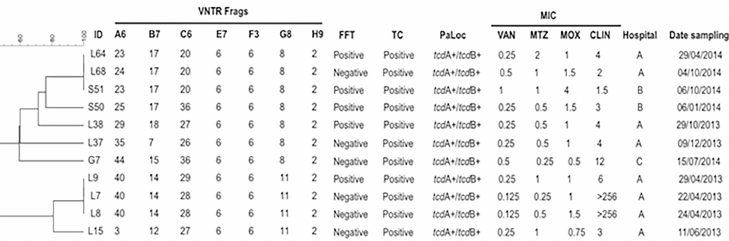
Fig 4. Analysis of ribotype 002 by MLVA. MLVA was applied to 11 isolates belonging to the ribotype 002. Dendrogram showing similarities of banding patterns generated with high-resolution capillary gel-based electrophoresis (CE)-PCR. MLVA clusters are identified by minimum-spanning tree: one clonal complex is defined by MLVA type with less than a two-locus difference. In addition, free fecal toxin A/B (FFT), toxin in cell culture (TC), presence of PaLoc genes ( tcd A/ tcd B), minimal inhibitory concentrations (MIC) for vancomycin (VAN), metronidazole (MTZ), moxifloxacin (MOX) and clindamycin (CLIN) are shown for each isolate with the respective breakpoints. VNTR, variable-number tandem repeat.